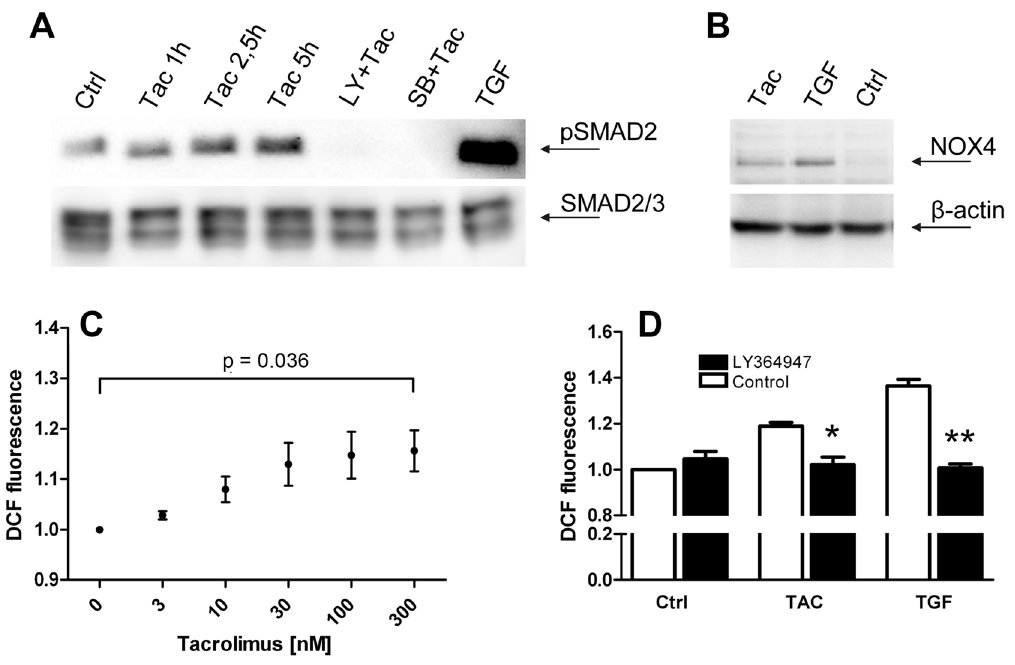
Figure 4. SMAD2 phosphorylation, and NOX4 expression and activity. Basal SMAD2 phosphorylation in untreated cells (Ctrl) is increased after 1 h, 2,5 h, and 5 h exposure to 100 nM tacrolimus (Tac). Preincubation with the TGF- b 1-RI kinase inhibitors LY364947, or SB-431542 before exposure to tacrolimus (LY + Tac, and SB + Tac, resp.) ablates phosphorylation of SMAD2. 10 ng/ml TGF- b 1 (TGF) served as a positive control. pSMAD2 band appeared at approx. 55 kD (A). Western blot for NOX4 protein in TK-173 fibroblasts treated over three days with 100 nM tacrolimus (Tac), 10 ng/ml TGF- b 1 (TGF), and untreated control cells (Ctrl). A specific Nox4 band at 60 kD is present after stimulation of the cells with tacrolimus or TGF- b 1, but undetectable in control cells (B). Intracellular H 2 O 2 levels in TK-173 cells, expressed as relative DCF (dichlorofluorescin) fluorescence, were increased by tacrolimus in a concentration-dependent manner, following a sigmoid curve (C). Co-application of the TGF- b 1-RI kinase inhibitor LY364947 significantly reduced intracellular H 2 O 2 concentrations to control levels in cells treated with 100 nM tacrolimus (TAC), or 10 ng/ml TGF- b 1 (D). Results were normalized to untreated control cells. doi:10.1371/journal.pone.0096377.g004 TGF- b 1, and suppressed gene expression below control levels, suggesting that tacrolimus might act through activation of the TGF- b receptor.